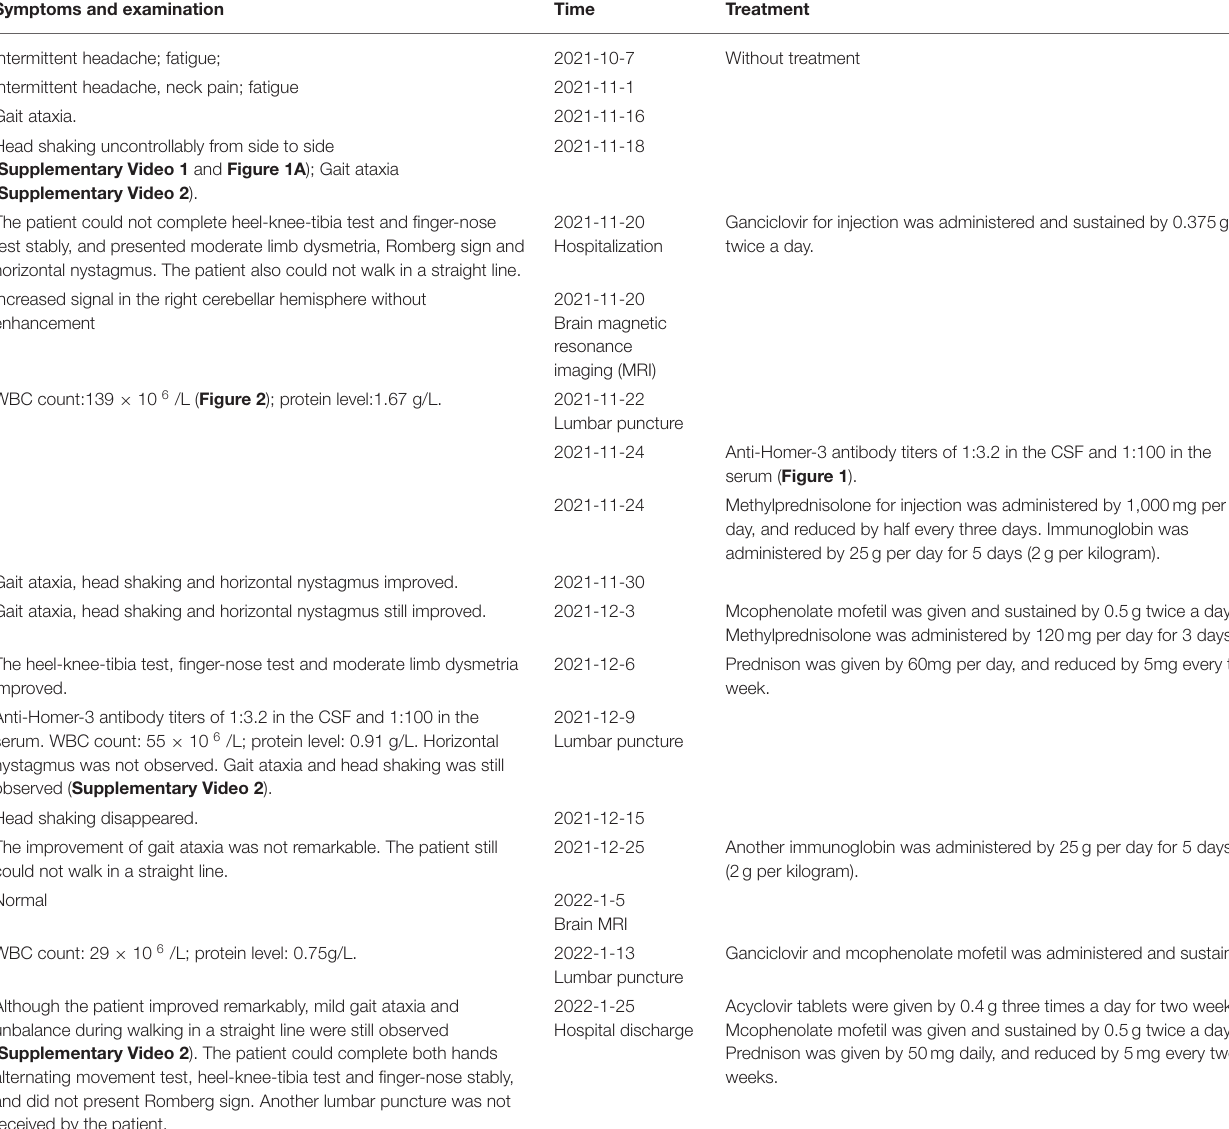
TABLE 1 | The symptoms and treatment in the patient according to timeline. Symptoms and